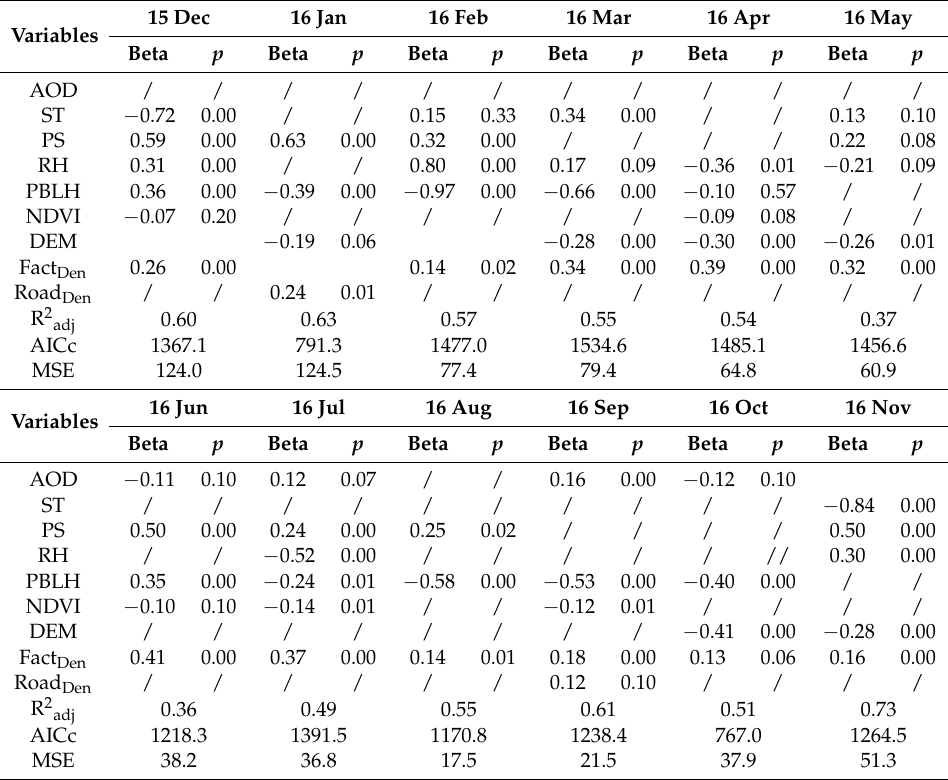
Table 6. Standardized coefficients and p -values of monthly PM 2.5 ESFR